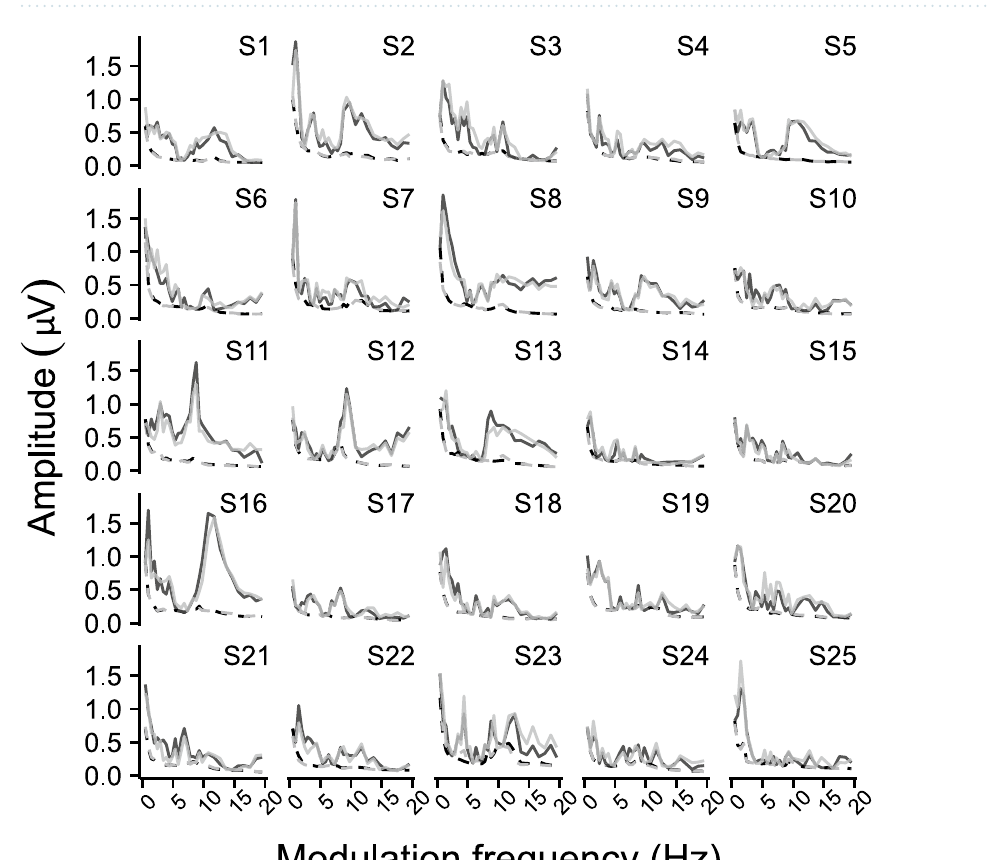
Figure 4. The correlation matrix of the biased response amplitudes across modulation frequencies for ( a ) the left and ( b ) the right hemispheric channel. Only p < 0.01 and r > 0 is shown. Four distinct patterns are apparent from the correlation matrixes, namely the correlation between 2.5 Hz and ~ 50–100 Hz, between 8 and 10 Hz and 10–20 Hz, the correlation between ASSRs within the 40–90 Hz region, and finally the correlation between ASSRs within the 80–100 Hz region. These patterns indicated that the response magnitude to a specific modulation frequency are associated with the response magnitude of the ASSRs that fall within a specific cluster.